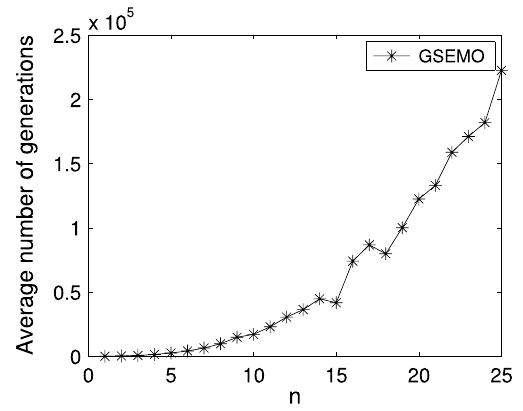
Fig. 4 The curve of average number of generations over 30 independ- ent runs for GSEMO to find the optimal solution to instance G ′ when n varies from 1 to 25, when the CMST problem of instance G ′ is transformed to a BMST